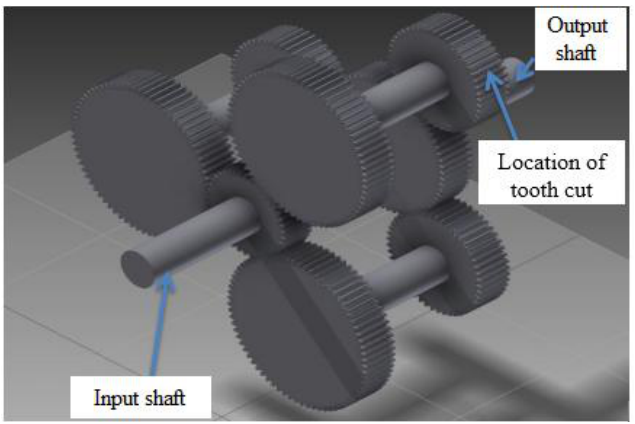
Figure 4. The structure of the notational split torque gearbox.